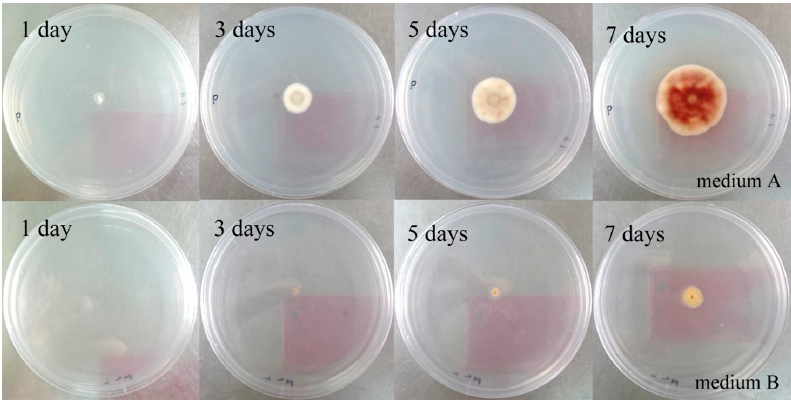
Figure 4. Fungal colonies in medium A (agar plates with PDA) and medium B (agar platess with PDA and 5 mM CoCl 2 ) after 1, 3, 5 and 7 days of incubation.